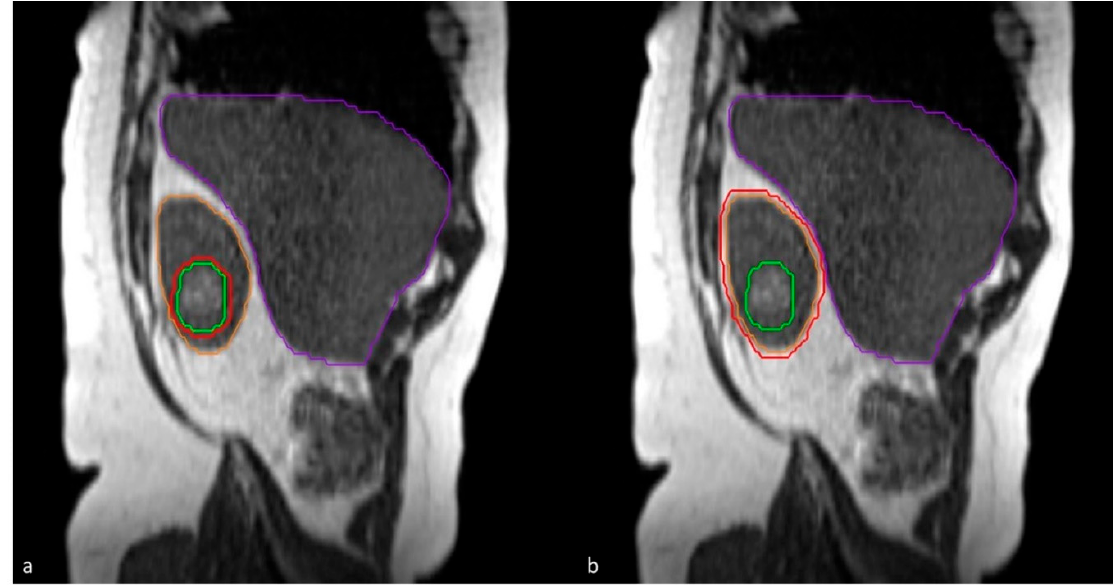
Figure 1. Sagittal plane for tumor tracking: either ( a ) tracking on gross tumor volume (green) or ( b ) tracking on the whole kidney (orange). A boundary of 3 mm (red) for gated delivery.